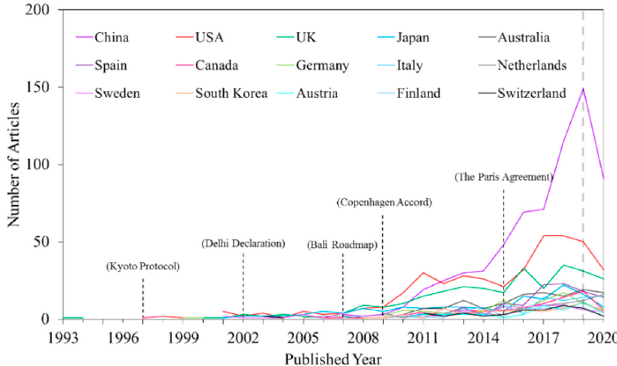
Figure 2. Contributions of the top 15 countries/territories to HCE research.